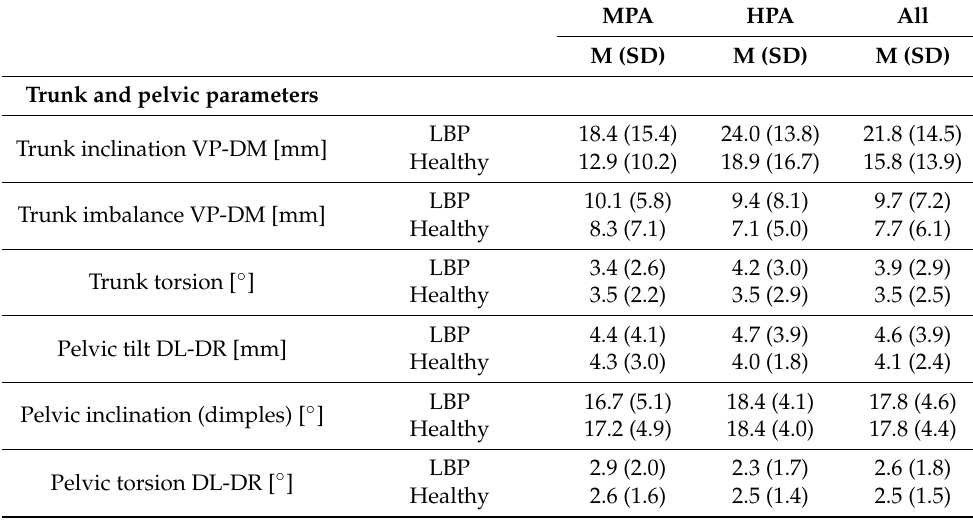
Table 5. Means and standard deviations for trunk alignment